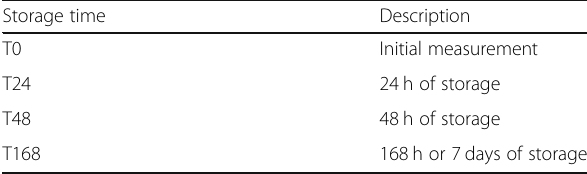
Table 1 Description of storage time Storage time